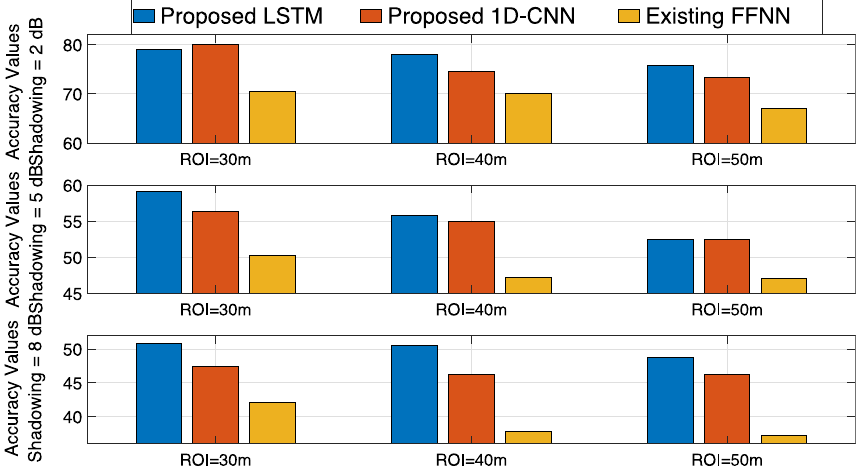
Fig. 13 TPRs of 1D CNN and LSTM at 8 dB shadowing with ensemble averaging in two-state